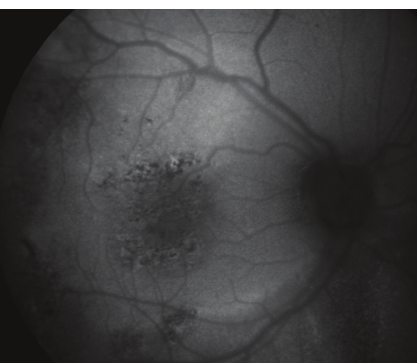
Figure 3: Fundus autofluorescence image taken 2 days after treatment. In the central part, visible alterations of the RPE with pigmentary changes (spots of hypofluorescence) and thermal RPE reaction (spots of hyperfluorescence). On the midperiphery, older retinal changes can be seen, due to previous serous fluid accumulation.